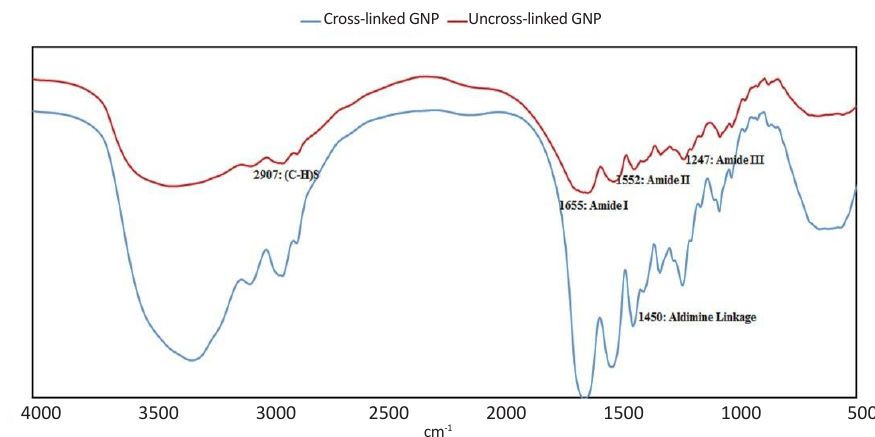
Fig. 5. FTIR spectra of crosslinked and un-crosslinked gelatin nanoparticles